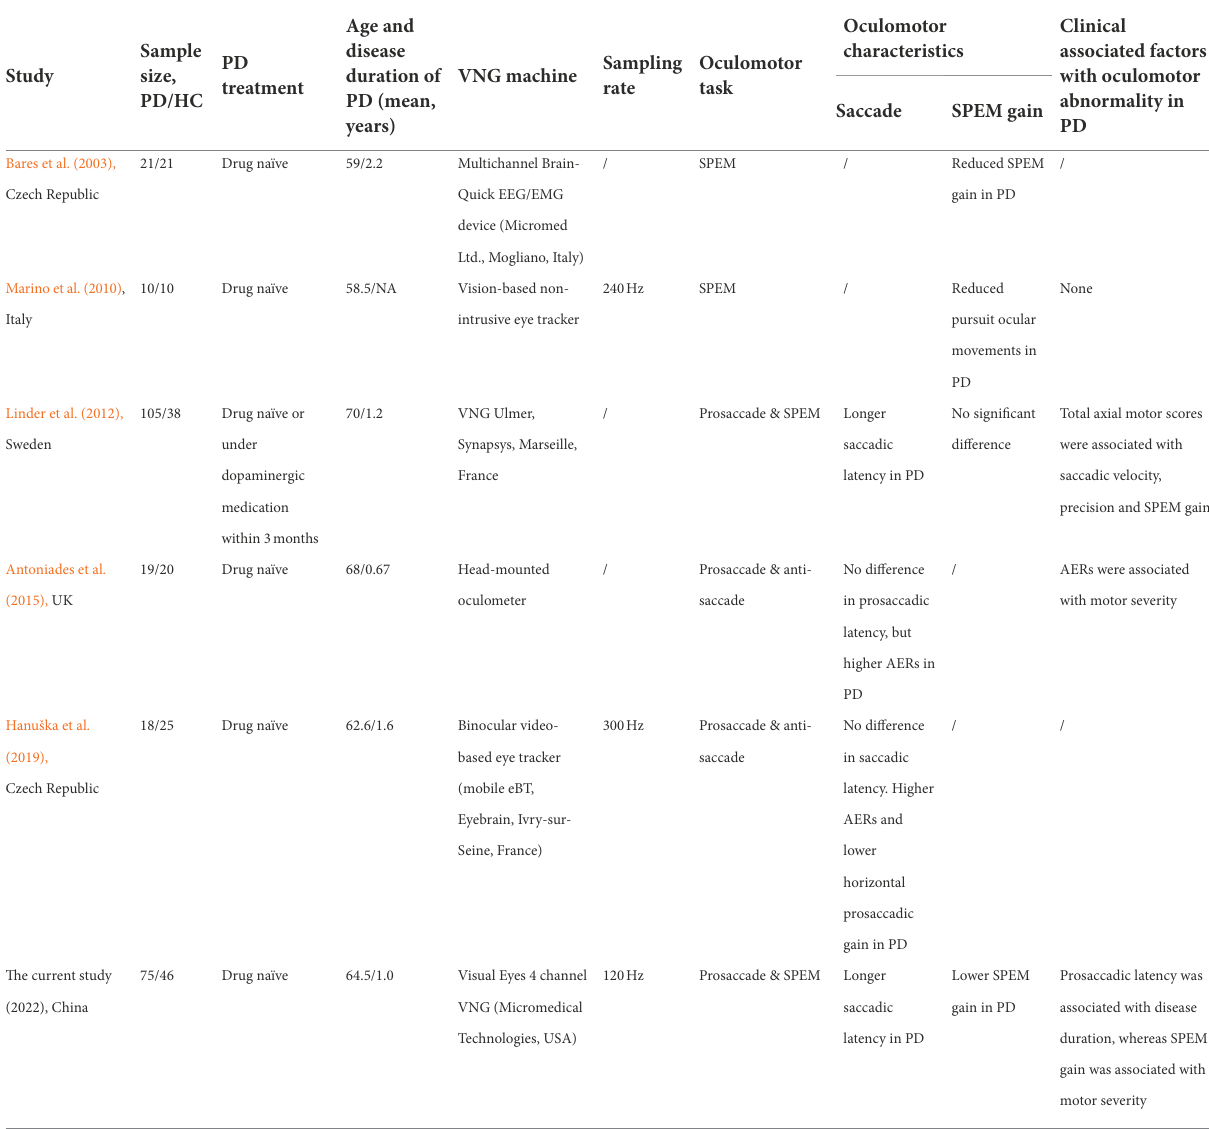
TABLE 5 Serial studies on eye movement evaluations in de novo PD